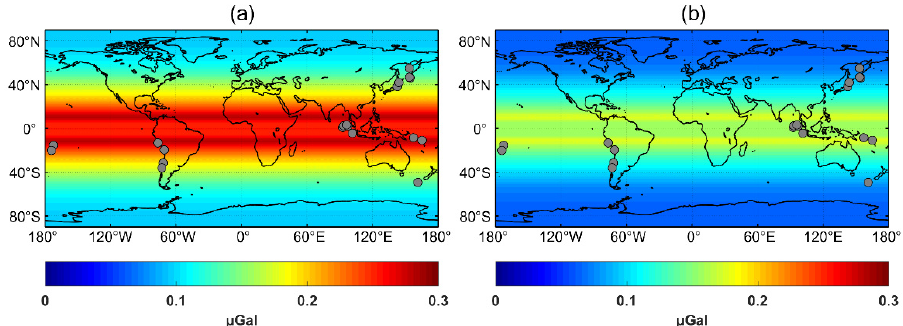
Figure 2. Global average error distribution of GRACE monthly time-variable gravity field model. The gray dots represent the locations of the earthquakes above Mw8.0 during GRACE mission, and the “beach balls” from global CMT catalog.